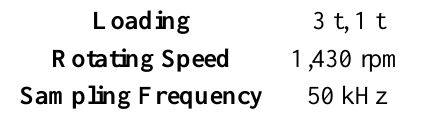
Table 2. Parameters used in the first